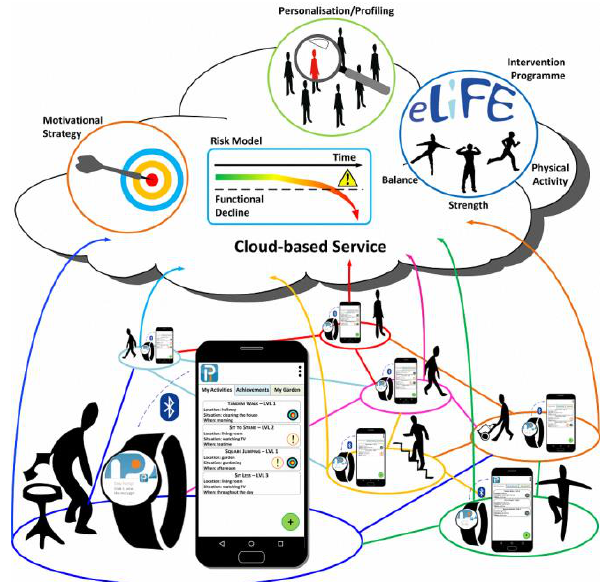
Figure 1. The architecture of the multifunctional PreventIT mHealth system, including risk screening for functional decline, profiling for personalisation of the intervention, an intervention with balance, strength, and physical activity integrated in daily life, and individual feedback on behaviour aimed at increasing motivation for behavioural change. A smartphone and a smartwatch are used for monitoring of behaviour, delivering the intervention, and for giving individualised feedback on behaviour.